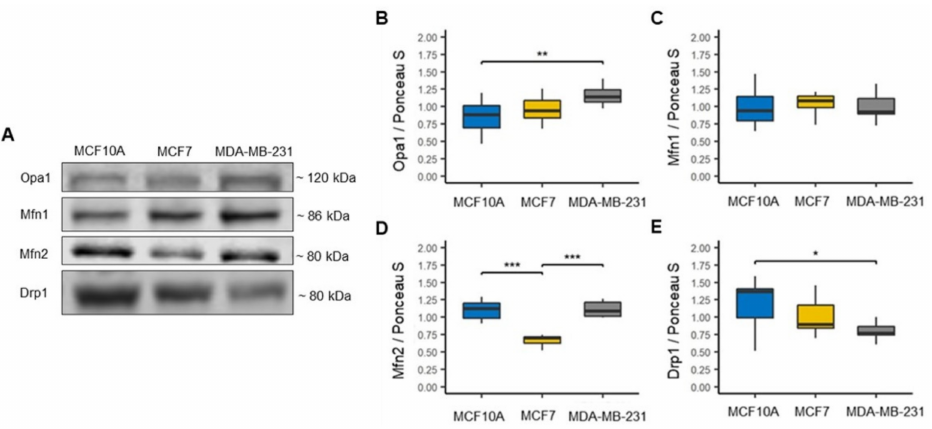
Figure 1. Mitochondrial dynamics in breast cancer cell lines. ( A ) Representative